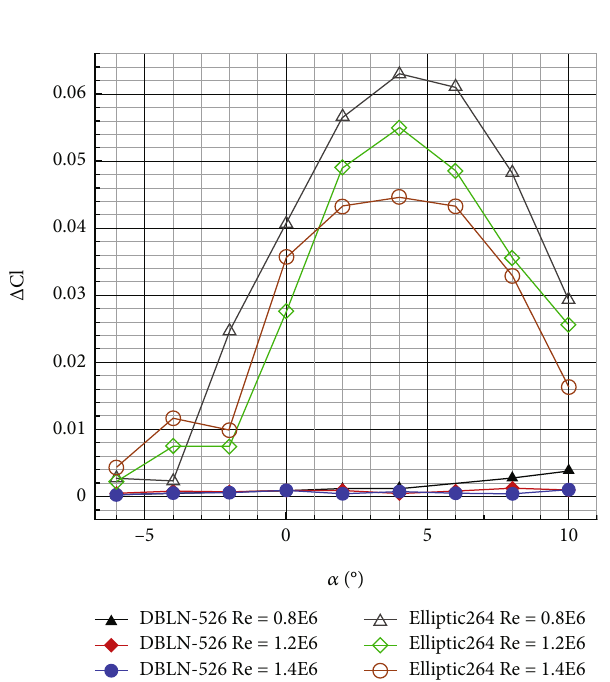
Figure 17: Comparison of Δ Cl for two airfoils.